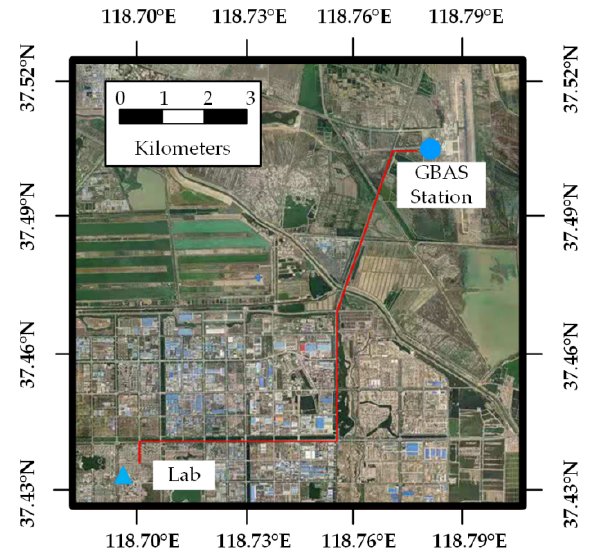
Figure 7. Motion trajectory of the land vehicle.